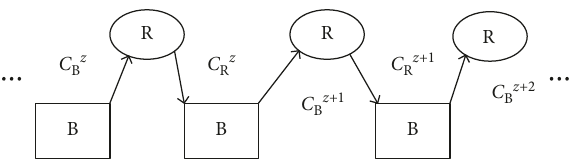
Figure 5: Schematic diagram of content input and output in the process of human-computer